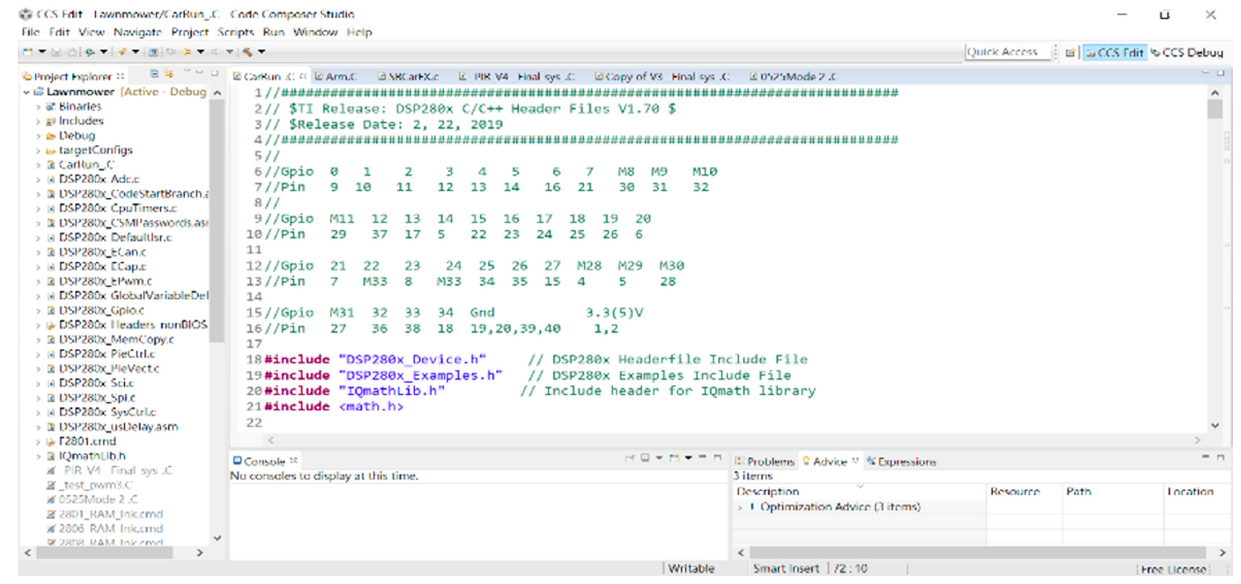
Figure 2. Environmental interface of Code Composer Studio (CCS) v6.0.